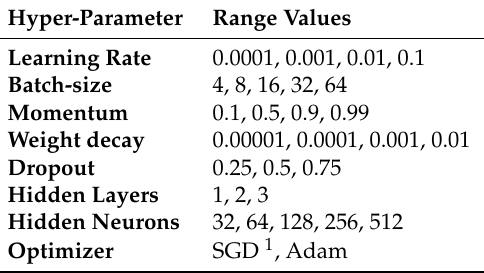
Table 2. Set of hyper-parameters values used in the search for the malignancy classification